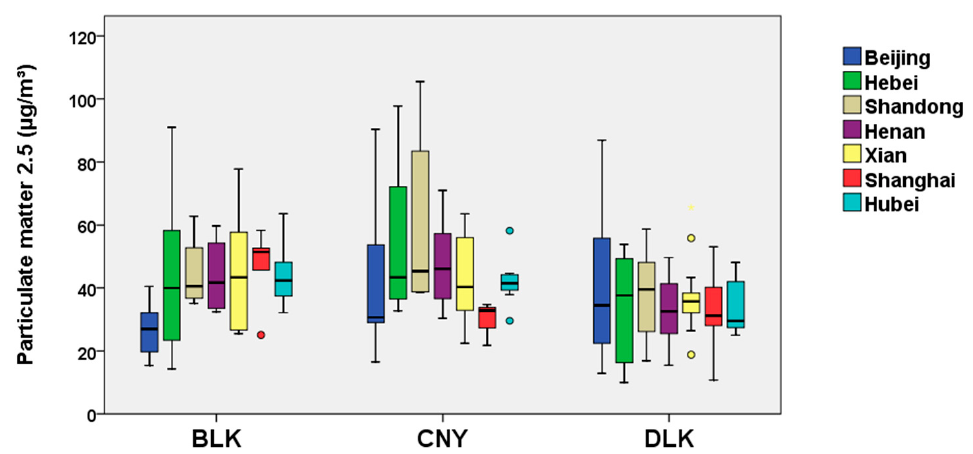
Figure 10. Daily mean satellite-derived PM 2.5 over seven regions of China during the consecutive study periods of BLK, CNY and DLK in early 2020. The horizontal bar dividing each interquartile range (box) represents the median value. The upper and lower quartiles represent the 75th and 25th percentiles, respectively. The upper and lower whiskers represent maximum and minimum values, excluding outliers. Individual dots represent statistical outliers.